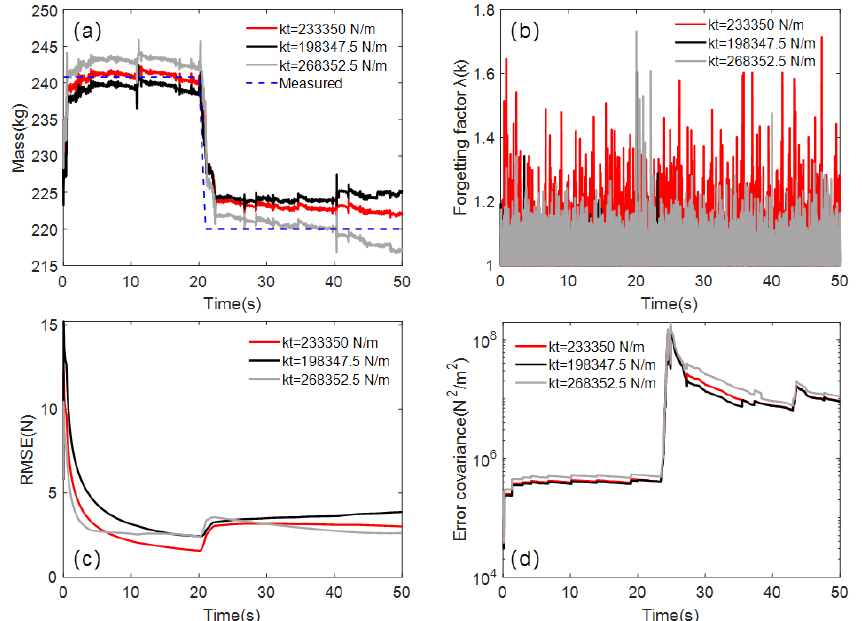
Figure 9. Simulation result of vehicle mass estimation with respect to different tire stiffness: ( a ) estimated vehicle mass (240 kg → 220 kg), ( b ) time evolution of the forgetting factor, ( c ) RMSE with respect to different tire stiffness, and ( d ) convergence history of error covariance. Table 2. Comparison of MRMSE for different tire